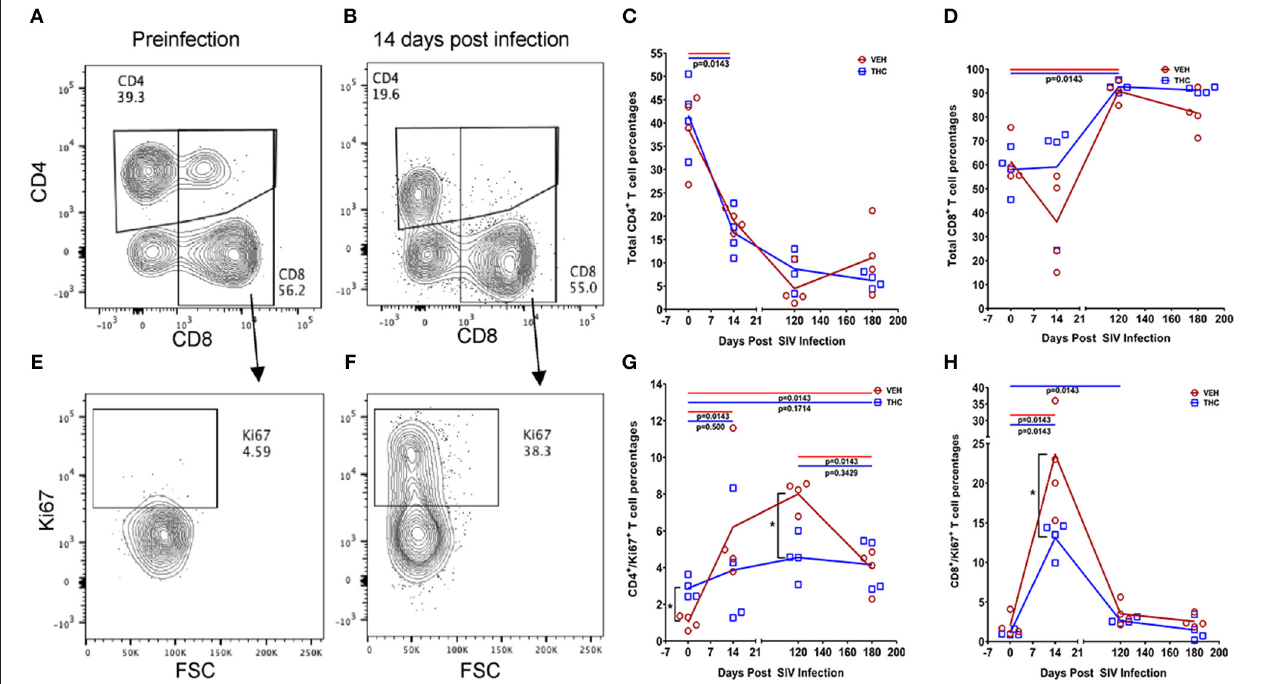
FIGURE 7 | Delta-9-tetrahydrocannabinol ( 1 9 -THC) administration regulates intestinal T cell proliferation/activation in SIV infection. A representative contour plot shows single positive CD4 + and double positive CD4 + /CD8 + T cell depletion in the intestine at 14 days post infection in a VEH/SIV rhesus macaque (A,B) . All acquired cells were first gated on singlets, followed by CD45 + and live cells. All live cells were further gated for CD3 + and CD20 + cells, where T cells were defined by gating for CD3 + T-cells. Finally, CD3 + T cells were analyzed for the presence of CD4 + and CD8 + phenotype. Total CD4 + T cell percentages are significantly reduced in intestines of both VEH/SIV and THC/SIV rhesus macaques as early as 14 days post-infection and remained low throughout the study period (C) . In contrast, total CD8 + T cell percentages were significantly increased in both VEH/SIV and THC/SIV rhesus macaques (D) at 120 days post-SIV infection. Contour plot shows CD8 + T cell proliferation/activation based on high Ki67 expression at 14 days post-SIV infection compared to the preinfection time point in a VEH/SIV rhesus macaque (E,F) . Within the gated CD4 + T cell population, note the significantly attenuated CD4 + T cell proliferation based on Ki67 expression in THC/SIV but not VEH/SIV rhesus macaques (G) at 14, 120-, and 180-days post-SIV infection compared to their respective preinfection levels. Similarly, 1 9 -THC significantly attenuated CD8 + T cell proliferation/activation associated with peak viral replication at 14 days post-SIV infection compared to VEH/SIV rhesus macaques (H) . Open red circles- VEH/SIV, Open blue squares- THC/SIV. Horizontal red and blue lines with P -values denote comparisons between time points within the VEH/SIV and THC/SIV groups, respectively. Left black brackets with an asterisk indicate statistical significance ( p = 0.0143) between the VEH/SIV and THC/SIV groups for a given time point. Connecting blue and red lines (C,D,G,H) denote mean values of the respective population in the THC/SIV and VEH/SIV groups, respectively. Flow cytometry analysis to determine the effect of 1 9 -THC on total CD4 + and CD8 + T cells and Ki67 expression in SIV-infected rhesus macaques was performed once with four individual animals as biological replicates per group. Flow cytometry data were analyzed using linear mixed models with immune-marker outcomes being dependent variables, and treatment status (VEH vs. 1 9 -THC) and days since the start of treatment (0, 14, 120, 180) being independent variables with fixed effects. Differences between two time points were analyzed using the Mann-Whitney U -test employing the Prism v5 software (GraphPad software). A p -value of ≤ 0.05 was considered